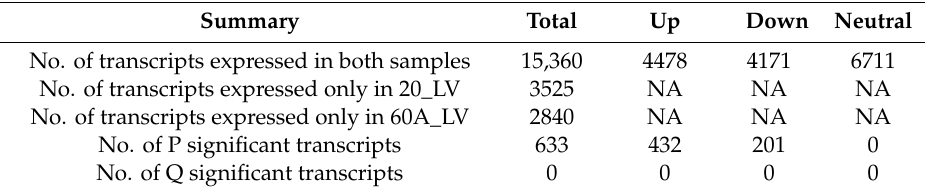
Figure 2. Volcano plot for differential gene expression. Fish feed with ( A ) 40% CHO vs. 20% CHO and ( B ) 60% CHO vs. 20% CHO. Scattered points represent genes: the x ‐ axis is the fold change for the ratio of treated vs. control, whereas the y ‐ axis is the statistic or ‐ Log 10 ( P ‐ value), which shows the probability that a gene has statistical significance in its differential expression. The green dots are thus genes significantly up ‐ regulated after treatment, red dots are genes significantly down ‐ regulated after treatment and black dots are genes significantly neutrally regulated after treatment. Table 2. Differential gene expression statistics for ( A ) 20_LV ‐ Vs ‐ 40_LV and ( B ) 20_LV ‐ Vs ‐ 60_LV.